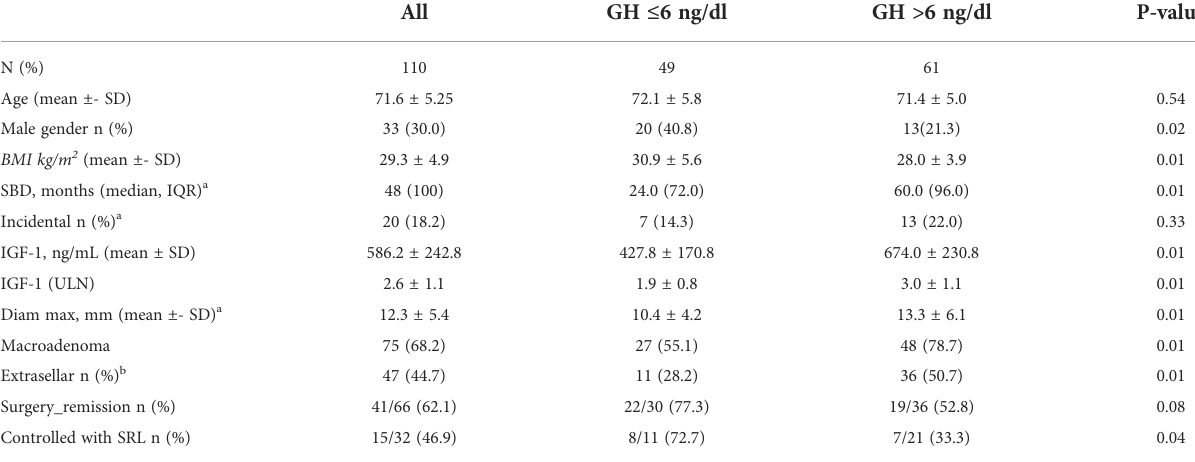
TABLE 3 Clinical characteristics and therapeutic response according to GH levels.